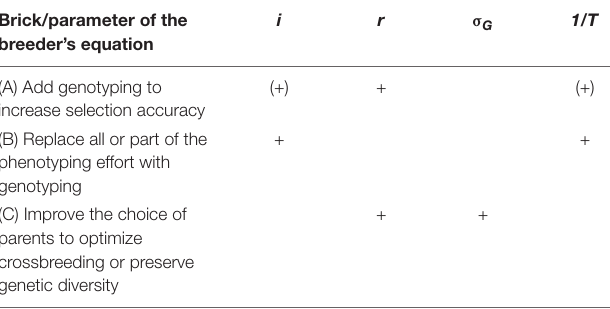
TABLE 1 | Impact of each brick on the parameters of the breeder’s equation. Brick/parameter of the breeder’s